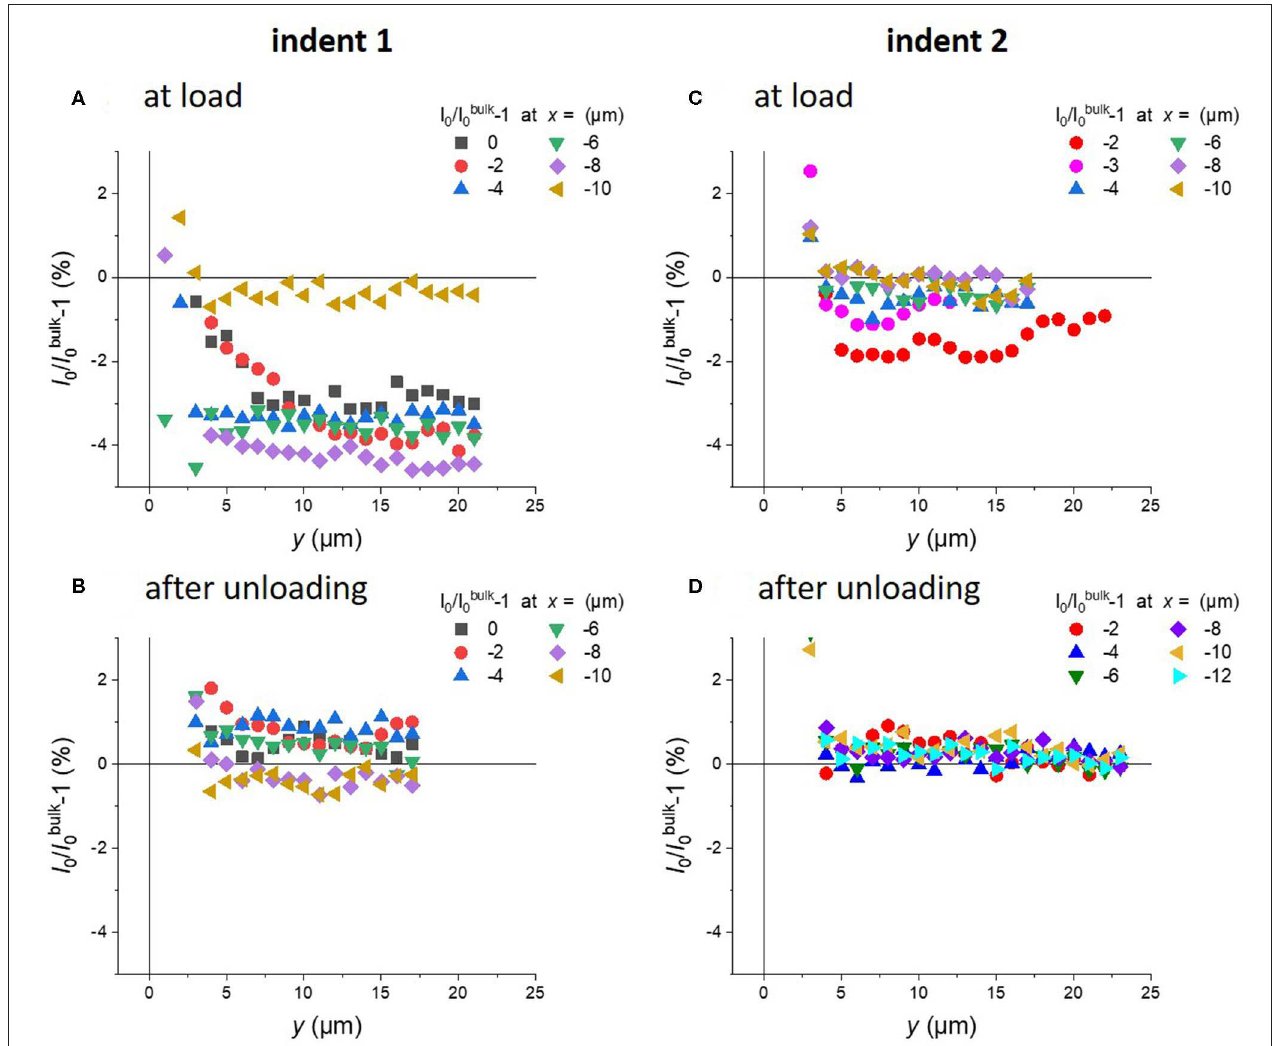
FIGURE 3 | Variation of the scattering intensity I 0 for vitreous silica during loading (A,C) and after unloading (B,D) . For comparability, the values of I 0 were normalized to the level of the pristine bulk glass, I 0bulk . Experimental data are shown as functions of the distance from the specimen surface in y- direction for various distances x relative to the loading axis (see Figure 2 for